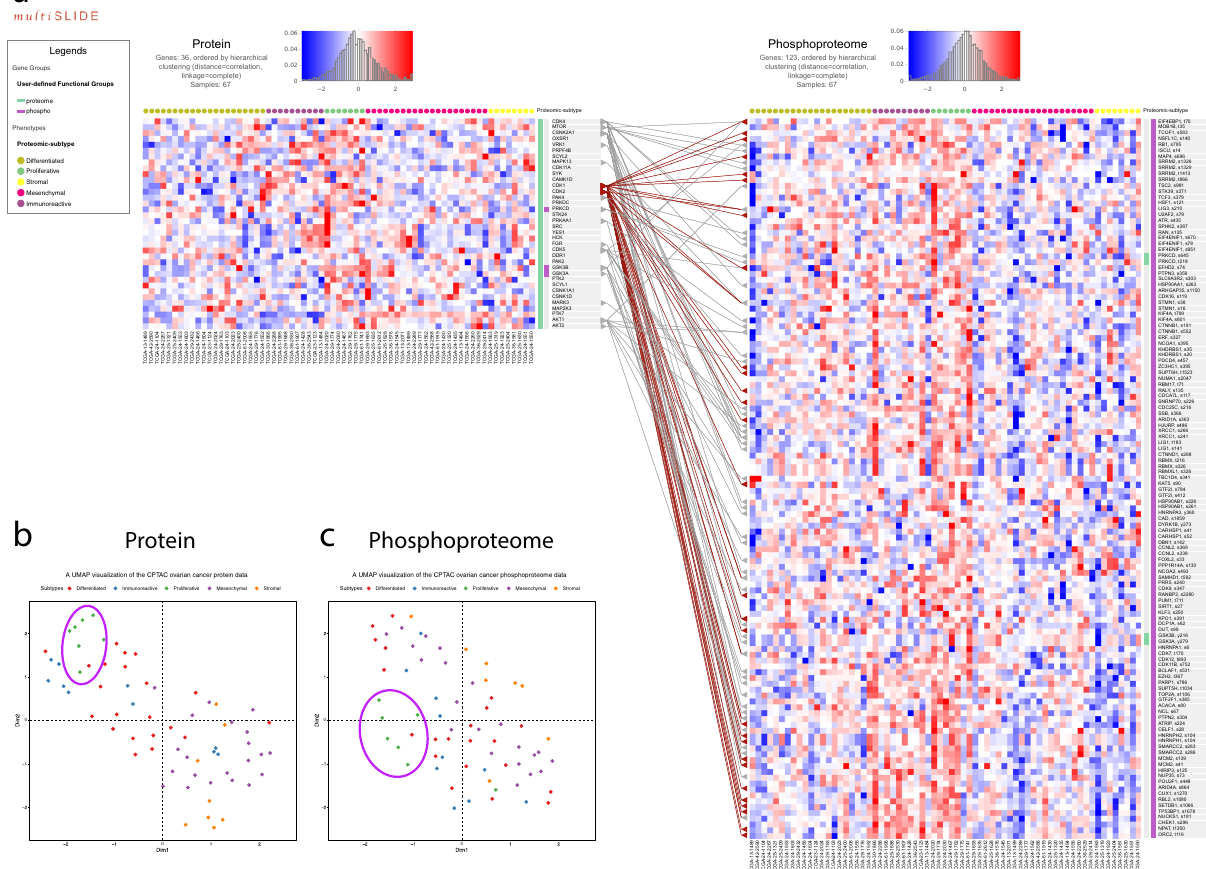
Fig. 3 Visualization of kinase-substrate relationships in the CPTAC Ovarian Cancer data. a Visualization of the subset of kinases-substrate pairs, which are upregulated in the proliferative subtype. The custom “ Upload ” option is used to select the molecules here. Kinase-substrate interactions were curated from PhosphoSitePlus 31 , PhosphoNetworks 32 , and a predictive network inference approach 33 to build a kinase-substrate map, which was uploaded into multiSLIDE using the upload network feature. The connecting lines show these curated relationships, with the highlighted (brown) lines connecting cyclin- dependent kinases CDK1 and CDK2 with known substrates. Supplementary Fig. S5 visualizes all the kinases-substrate pairs. b A UMAP visualization of the whole proteomics data for 3329 proteins. The ellipse highlights a cluster of proliferative subtype patients in the protein data. c A UMAP visualization of the whole phosphoproteome data for 5746 phosphosites. The ellipsis highlights a cluster of proliferative subtype patients in the phosphoproteome